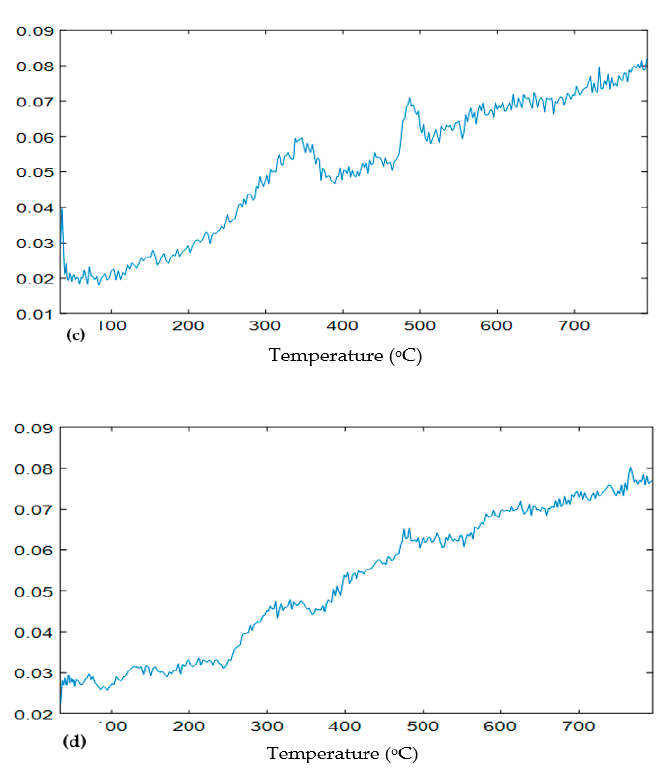
Figure 8. Loadings of the PARAFAC model. ( a ) Mode 2 loadings of component 3 (TGIS), ( b ) mode 2 loadings of component 3 (TGO), ( c ) mode 3 loadings of component 3 (TGIS), and ( d ) mode 3 loadings of component 3 (TGO). X-values are wavenumber cm − 1 in ( a , b ) and temperature °C in ( c , d ). Y-values are scaled values of the components.